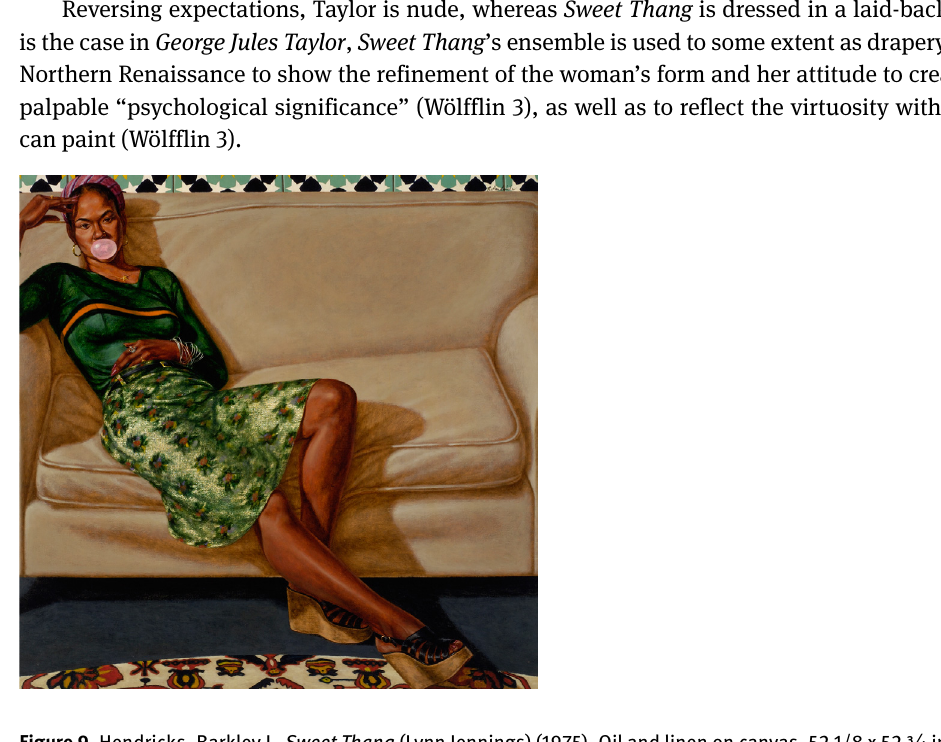
Figure 9. Hendricks, Barkley L. Sweet Thang (Lynn Jennings) (1975). Oil and linen on canvas, 52 1/8 x 52 ¾ in. ©Estate of Barkley L. Hendricks. Courtesy of Jack Shainman Gallery, New